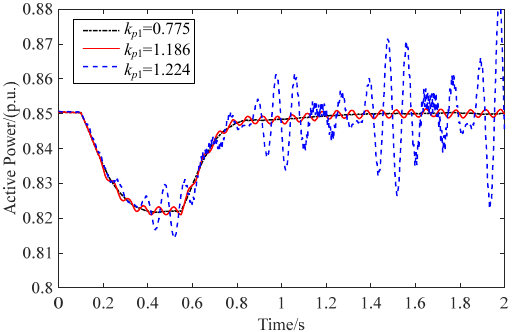
Figure 4. Relationship of PMSG parameter setting and stability.